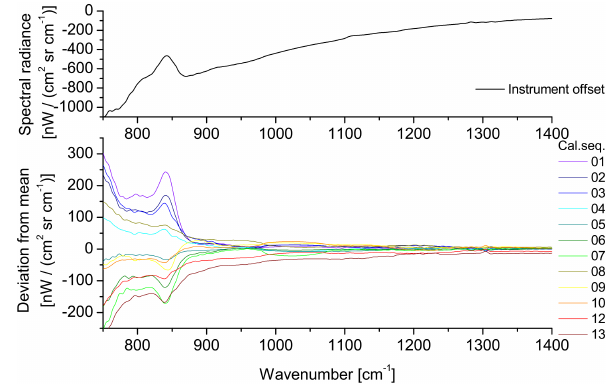
Figure 17. Mean gain function and relative deviation from the mean for the different calibration sequences during the HALO flight on 13 September 2012.